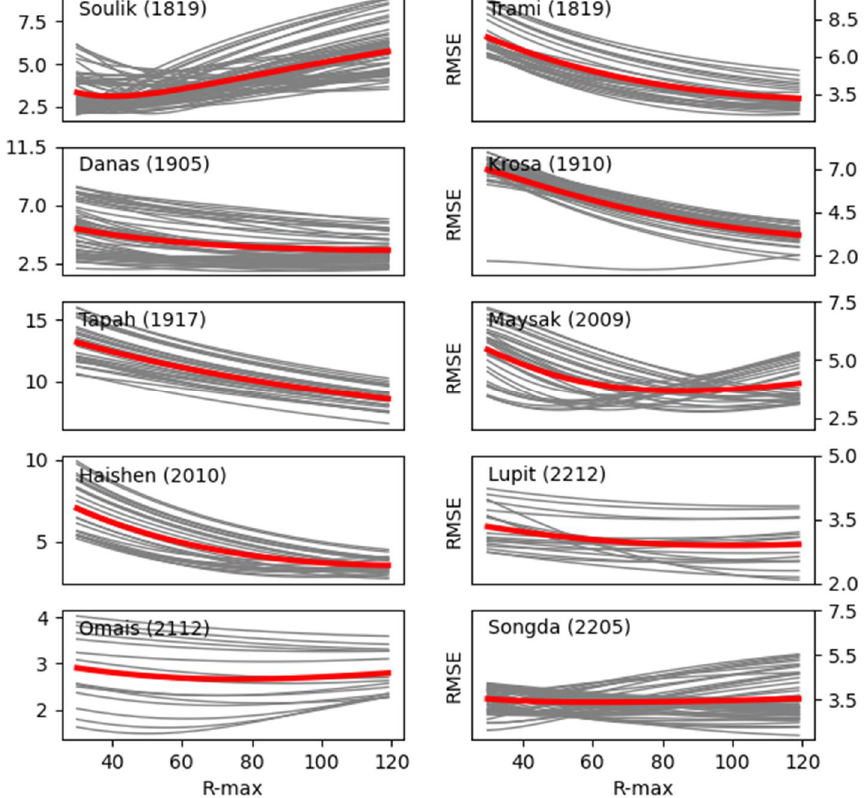
Figure 3. Root mean square error (RMSE) between observational surface wind speed and parametric typhoon model output with variations of typhoon Rmax. Y-axis denotes RMSE (m/s), and x-axis shows Rmax (km). Of the 23 typhoon cases, only 10 results are plotted as examples.